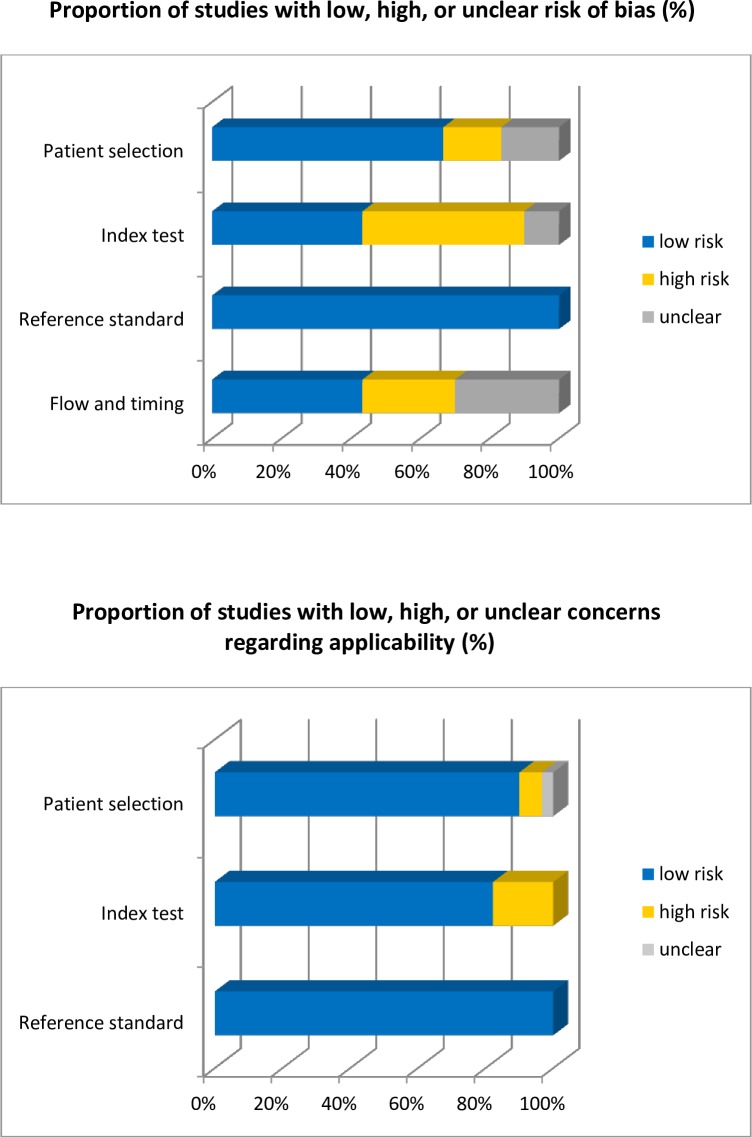
Overall risk of bias in meta-analysis.This figure illustrates the overall risk of bias in the meta-analysis. The horizontal axis represents the number of studies included. The color of the bars represent the risk of bias. Yellow: high risk, blue: low risk and grey: unclear risk.